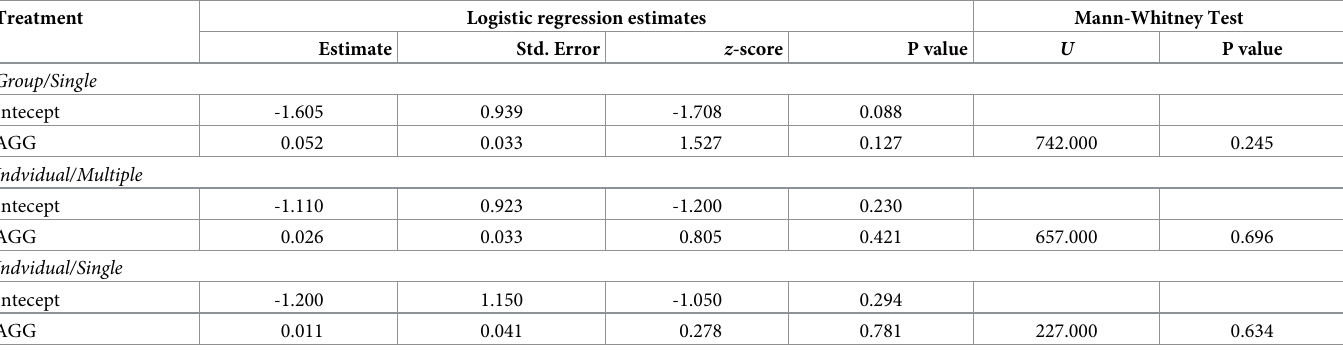
Table 8. Aggression and investing in the control treatments. The table presents the results of univariate Logistic regressions in which the decision, to invest is the depen- dent variable and the independent variable is measured aggression as well as the results of a Mann-Whitney test for the null hypothesis that the median aggression scores of investing and tracking subjects are